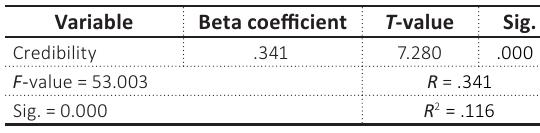
Table 13. Simple linear regression for testing the third hypothesis